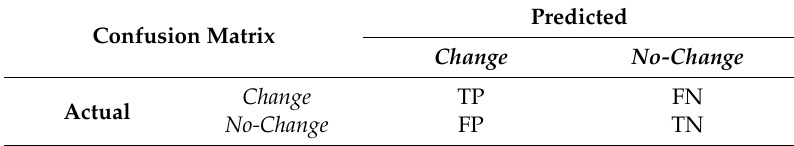
Table 4. Confusion matrix (TP: True Positive, TN: True Negative, FP: False Positive, and FN: False Negative).